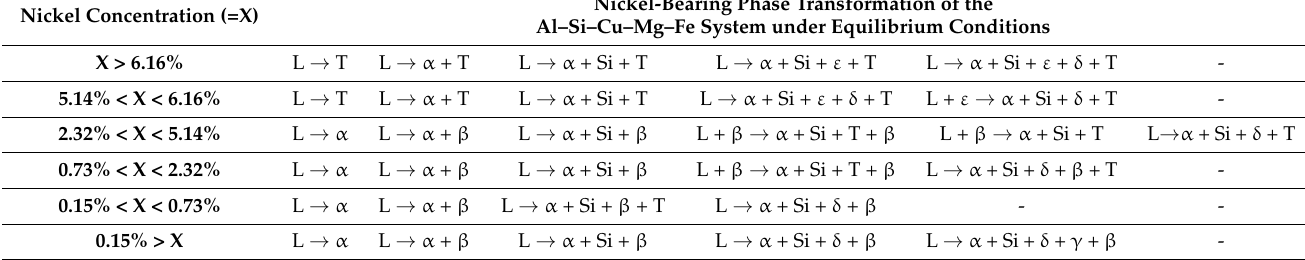
Table 5. Nickel-bearing phase transformation of the Al–Si–Cu–Mg–Fe system under equilibrium conditions at different nickel